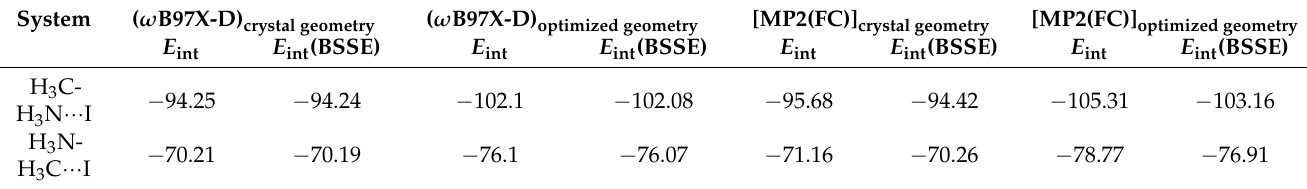
Table 1. Uncorrected and BSSE corrected Self-Consistent Fieldinteraction energies ( E int and E int (BSSE), respectively) of H 3 C-H 3 N ··· I and H 3 N-H 3 C ··· I ion-pairs, obtained on the fixed crystal geometry,